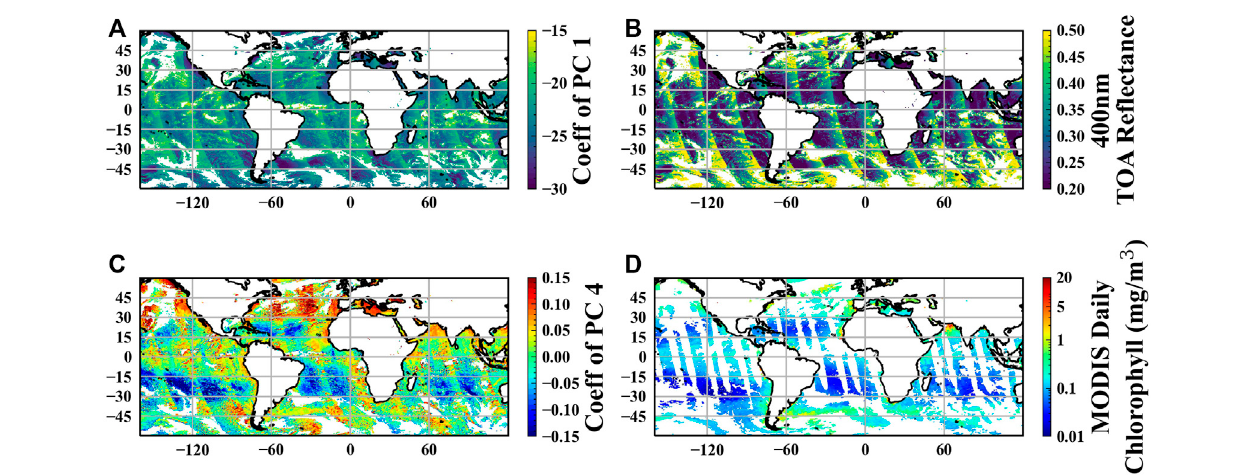
FIGURE 3 | OMI measurements and MODIS ocean color retrievals for 15 March 2005. (A) Coef fi cient of the fi rst PC; (B) 400 nm OMI-measured TOA re fl ectance; (C) coef fi cient of the fourth PC; (D) MODIS chlorophyll concentration co-located to OMI.